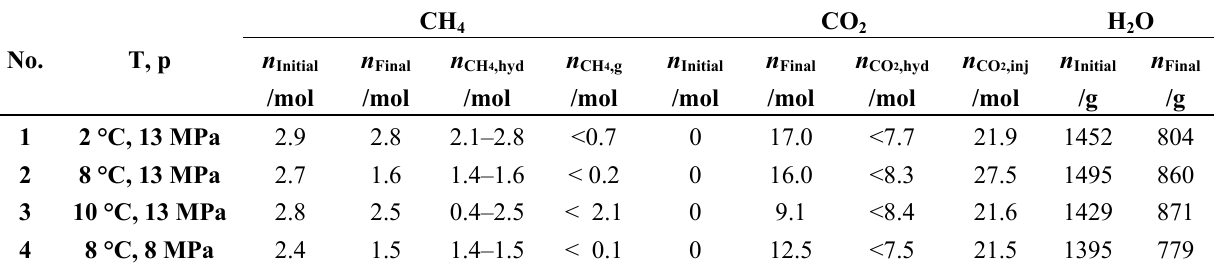
Table 4 . Component inventories and phase distribution. Initial and final component and phase inventories are shown. Final amounts of components n were calculated from mass final balance analysis. Amounts of gaseous CH in the pressure vessel were estimated from 4 volume differences. However, n is putatively underestimated in cases of rapid CH 4 ,g CO -hydrate formation, and overestimated if CH -hydrate reformation occurs. Final 2 4 hydrate inventories n and n are calculated from component inventories and CH 4 ,hyd CO 2 ,hyd show maximum values.